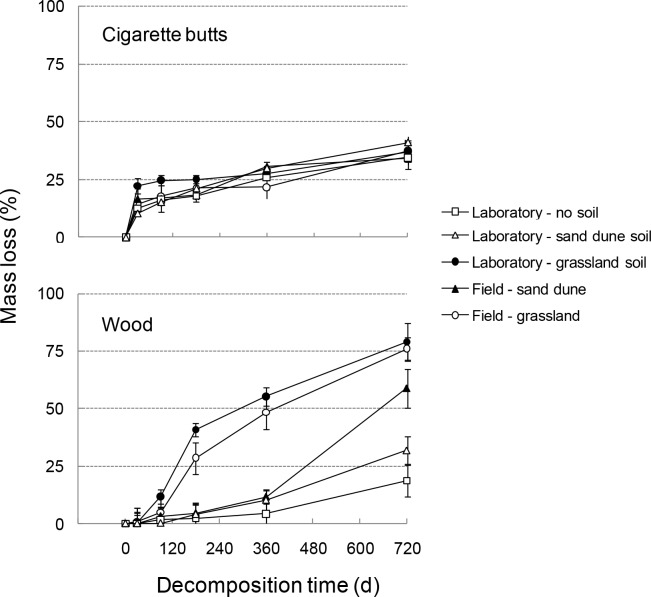
CB and wood sticks mass loss.Mass loss during a 720-day decomposition period for cigarette butts (above) and wood sticks (below) in laboratory and field conditions. Data refer to mean ± standard deviation of 25 replicates for each material (for statistics see S1 Table).